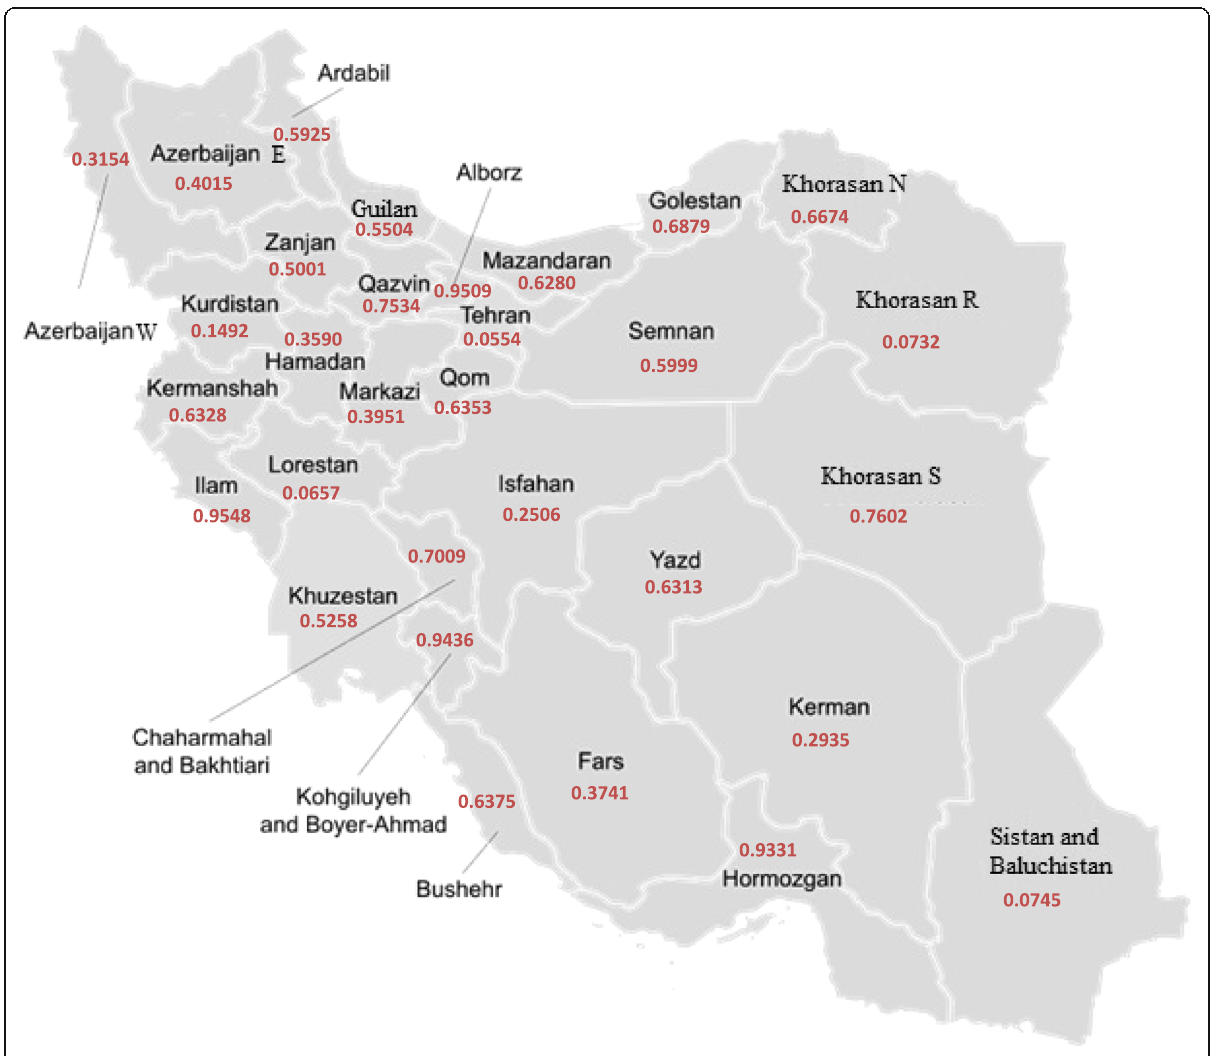
Fig. 3 Iranian road safety performance obtained using DF-SBM-ER for the year